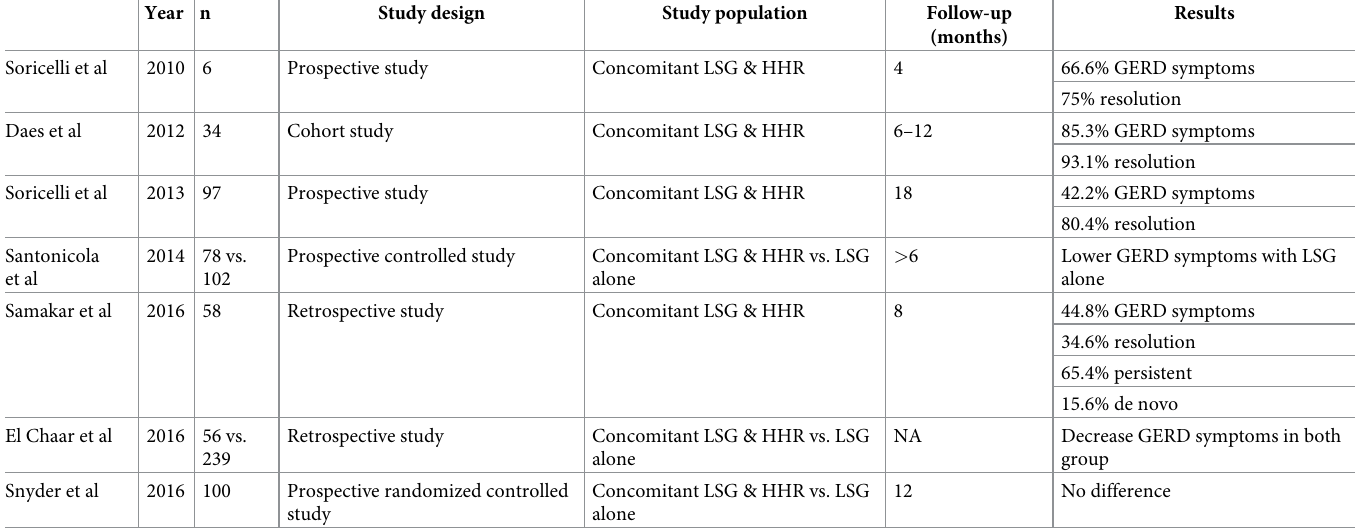
Table 4. Current evidence for concomitant sleeve gastrectomy with hiatal hernia